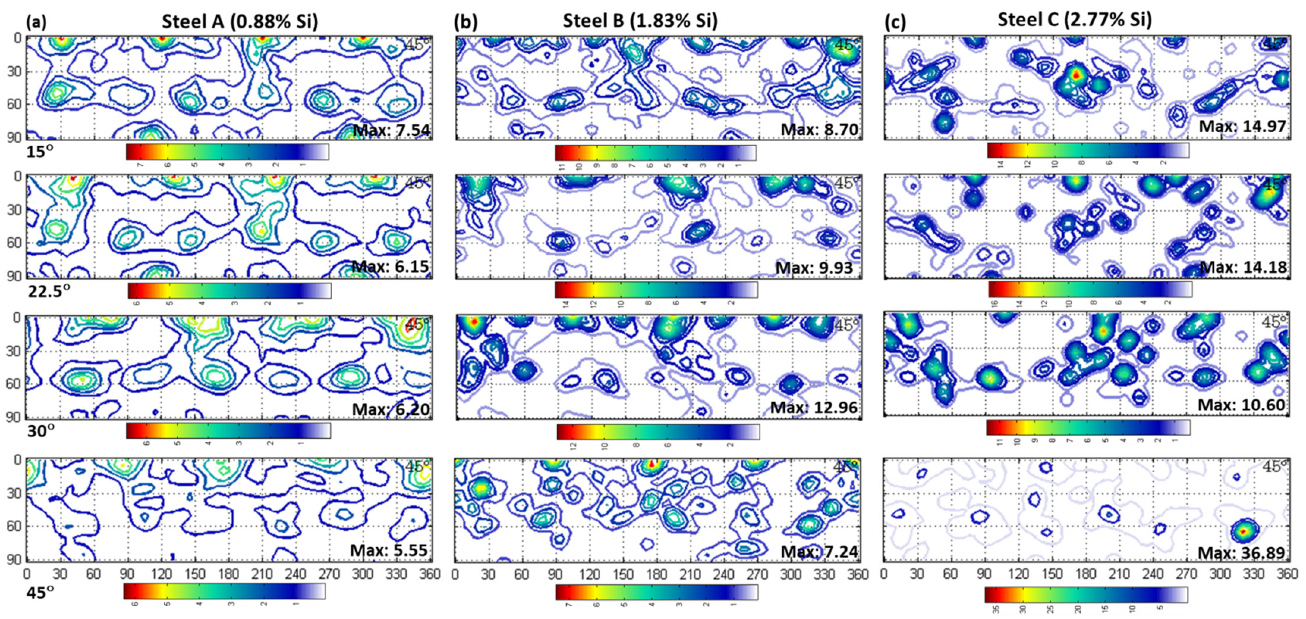
Figure 10. Textures of the skew-cold-rolled steels (bidirectional feeding) after annealing: ( a ) Steel A, ( b ) Steel B and ( c ) Steel C. ϕ 2 = 45° sections of the Euler space (Bunge notation).